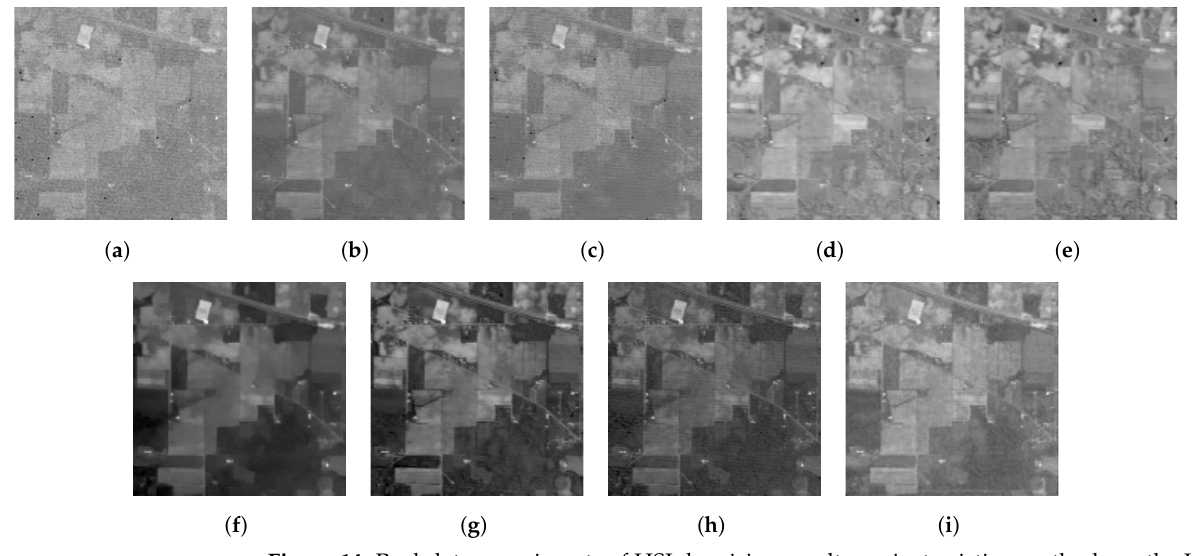
Figure 14. Real-data experiments of HSI denoising results against existing methods on the Indian Pines dataset: ( a ) original image of band 1; ( b ) NNM; ( c ) BM4D; ( d ) WNNM; ( e ) WSNM; ( f ) LRTDTV;